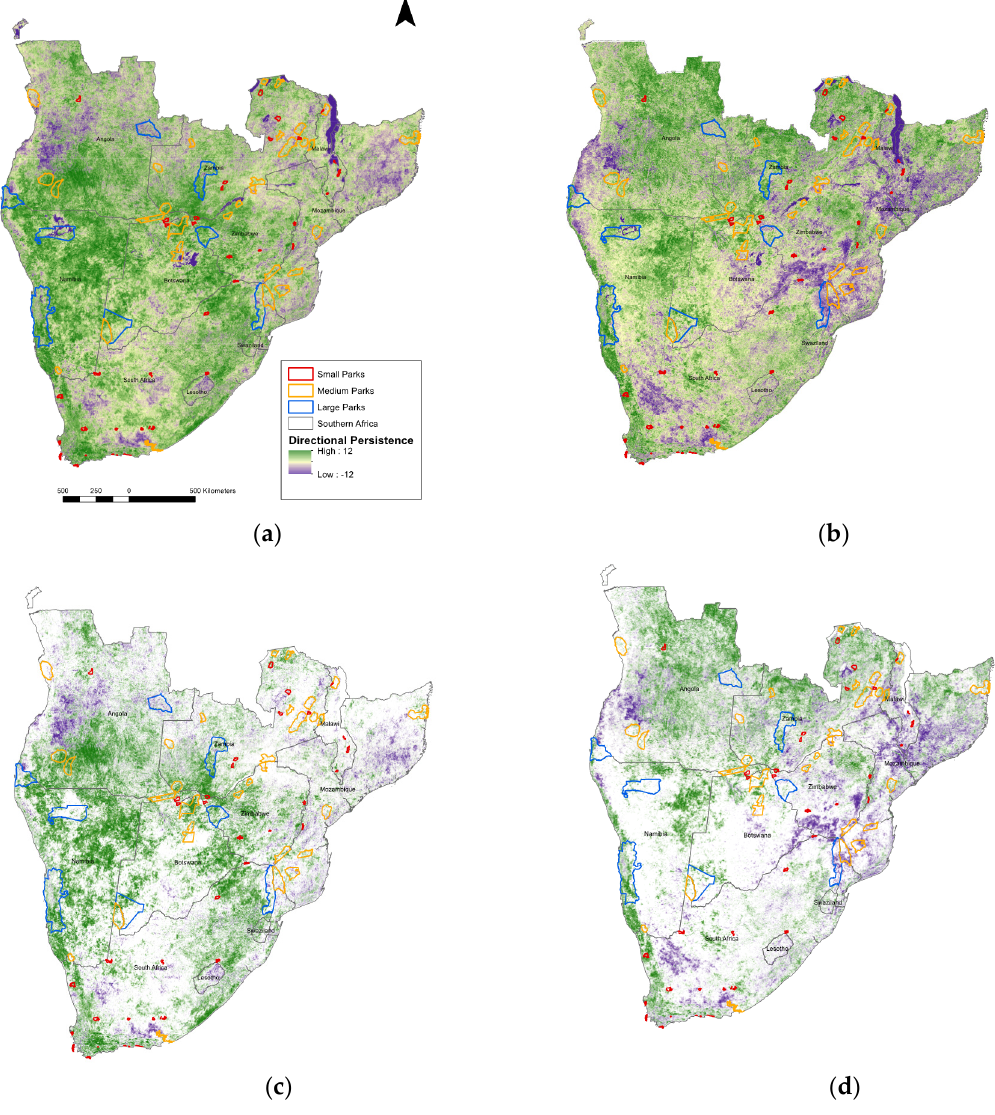
Figure 3. Directional persistence mapped across southern Africa in (a) all values in December, January, February; (b) all values in March, April, May; (c) significant values in December, January, February; and (d) significant values in March, April, May.